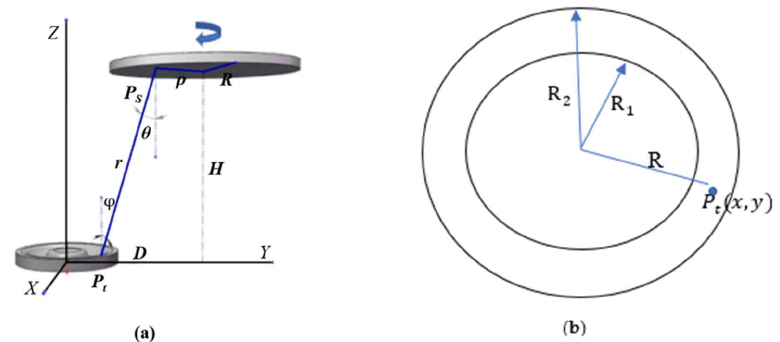
Figure 18. ( a ) Rotating planar substrate holder and circular sputtering target, where H is the distance between the target plane and the substrate holder plane, φ is the angle between the normal of the target and the line connecting the P t point to the P s point; θ is the angle between the normal of the substrate and the line connecting the P t point to the P s point; r is the distance from the P t point to the P s point; ρ is the distance from the point P s to the center of the substrate; D is the horizontal distance from the target center to the substrate holder center; P s ( x 1 , y 1 ) is any point on the substrate holder; P t ( x , y ) is any point on the target; ( b ) 2D projection of target, where R 1 is the inner ring radius; R 2 is the outer ring radius; and R is the distance from the P t point to the center of the target.